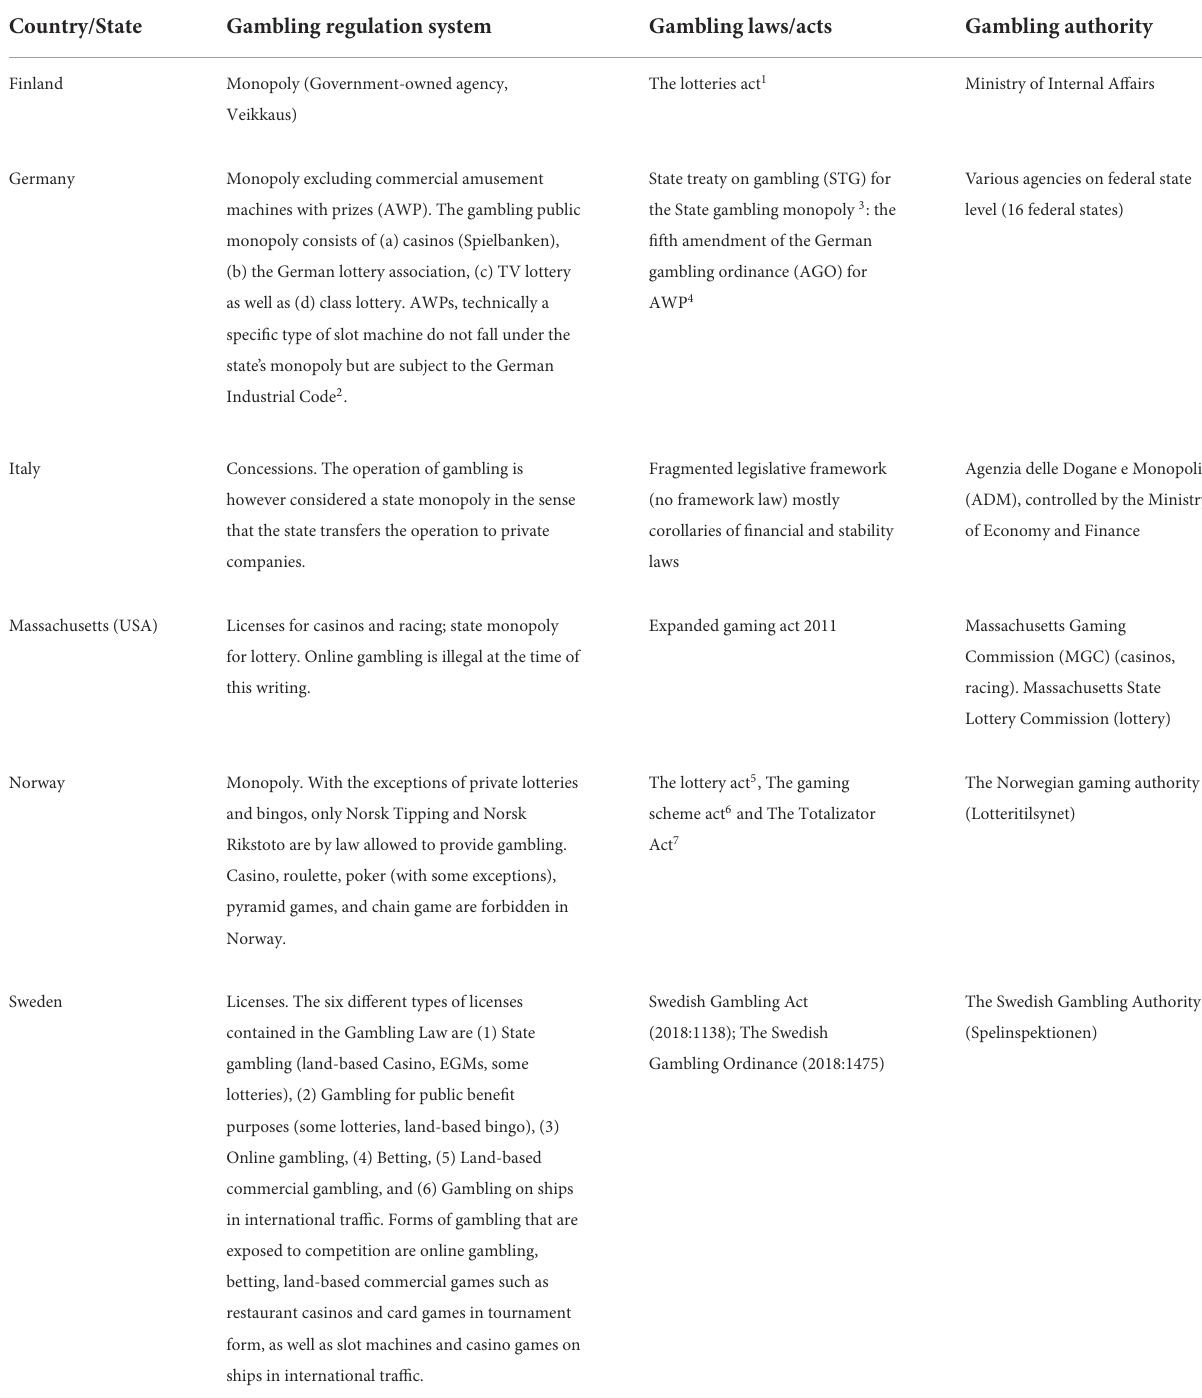
TABLE 1 Summary of gambling frameworks by